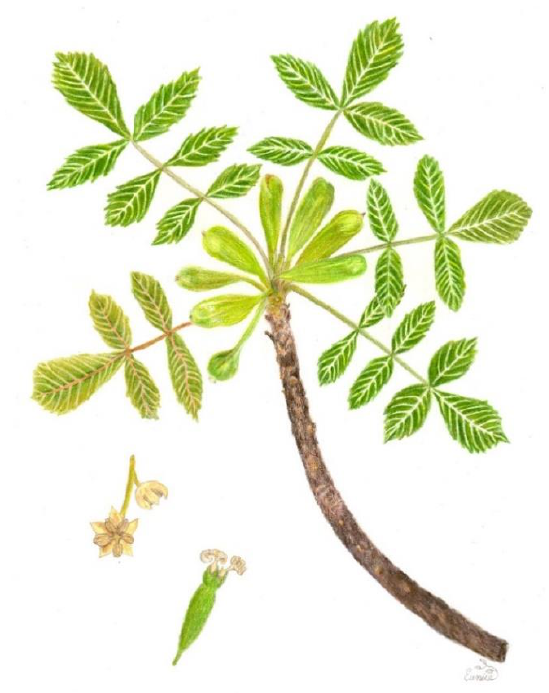
Figure 3. A. adstringens sketch showing the structure of the leaves, fruits, and male (left) and female (right) flowers. Color pencil drawing by Eunice Romero, 2022.